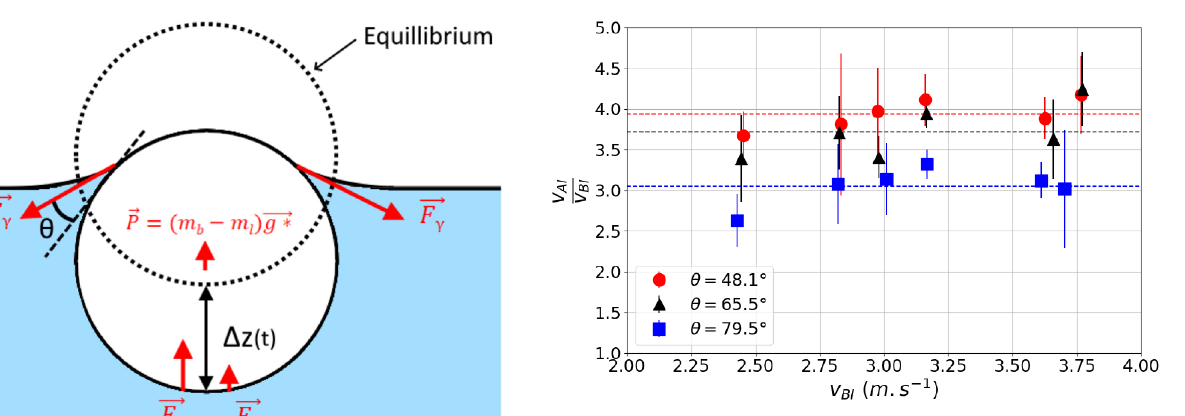
Fig. 5. Velocity ratio as a function of ball velocity before impact. We find highest speed transmission for the ball with highest wetting